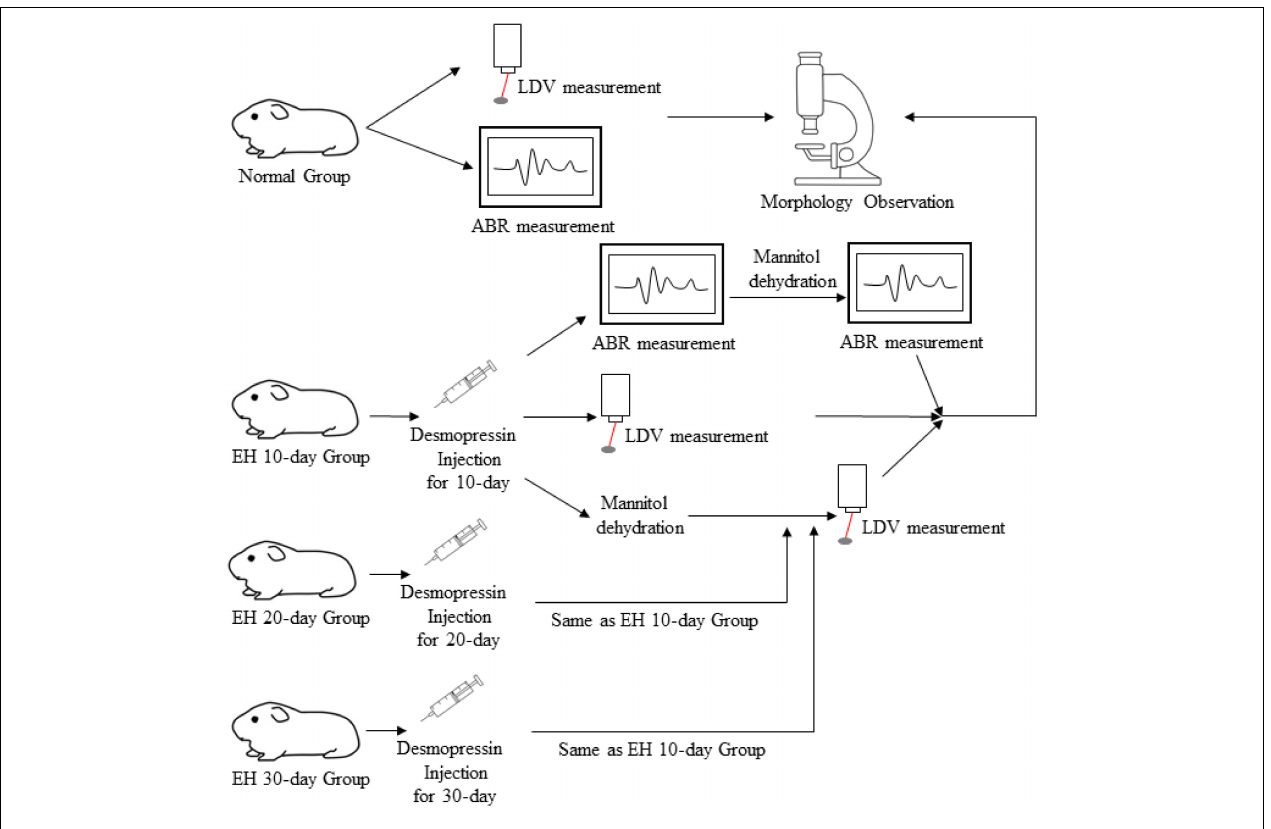
FIGURE 1 | The experimental